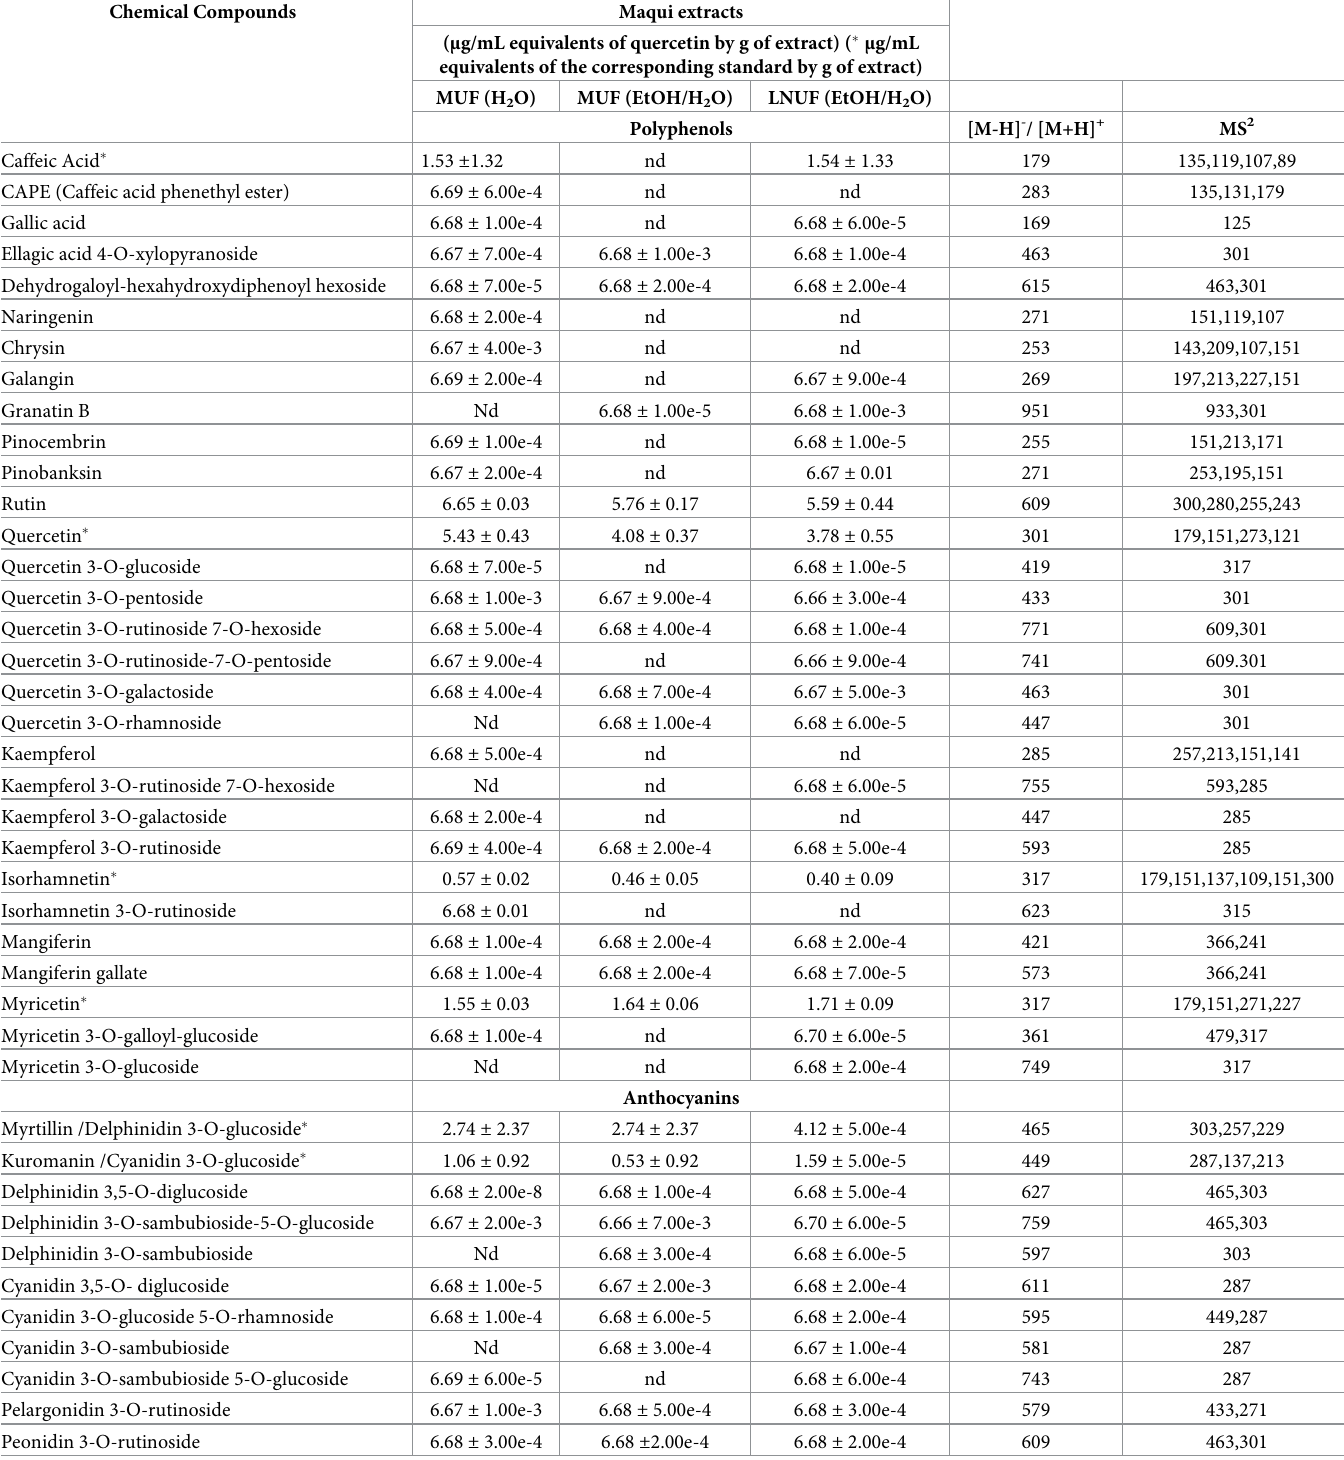
Table 3. Chemical characterization of Luna Nueva and Morena unripe maqui extracts by HPLC-MS/MS. Chemical